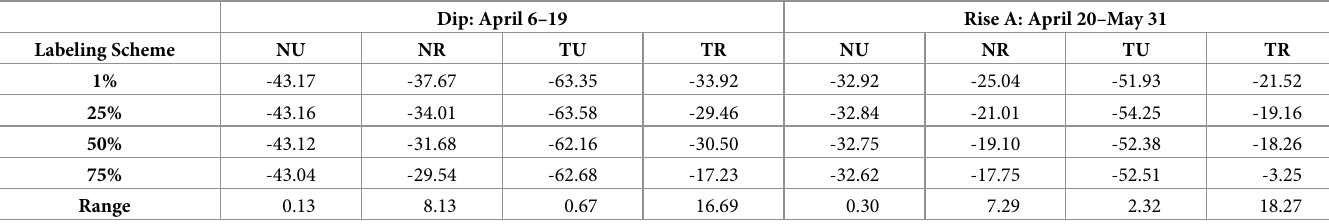
Table 2. Median daily mobility across different labeling schemes for cluster categories in SoCal. The “Range” row shows the absolute difference between the lowest per- centage point and the highest in each